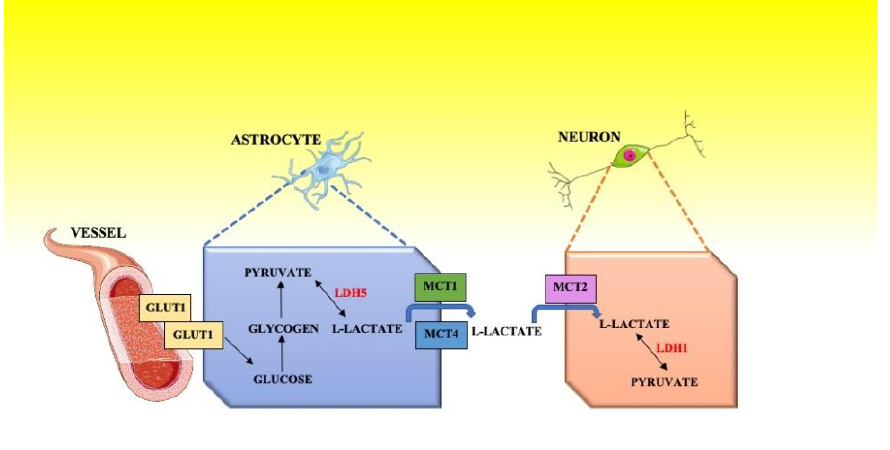
Figure 1. Shuttle